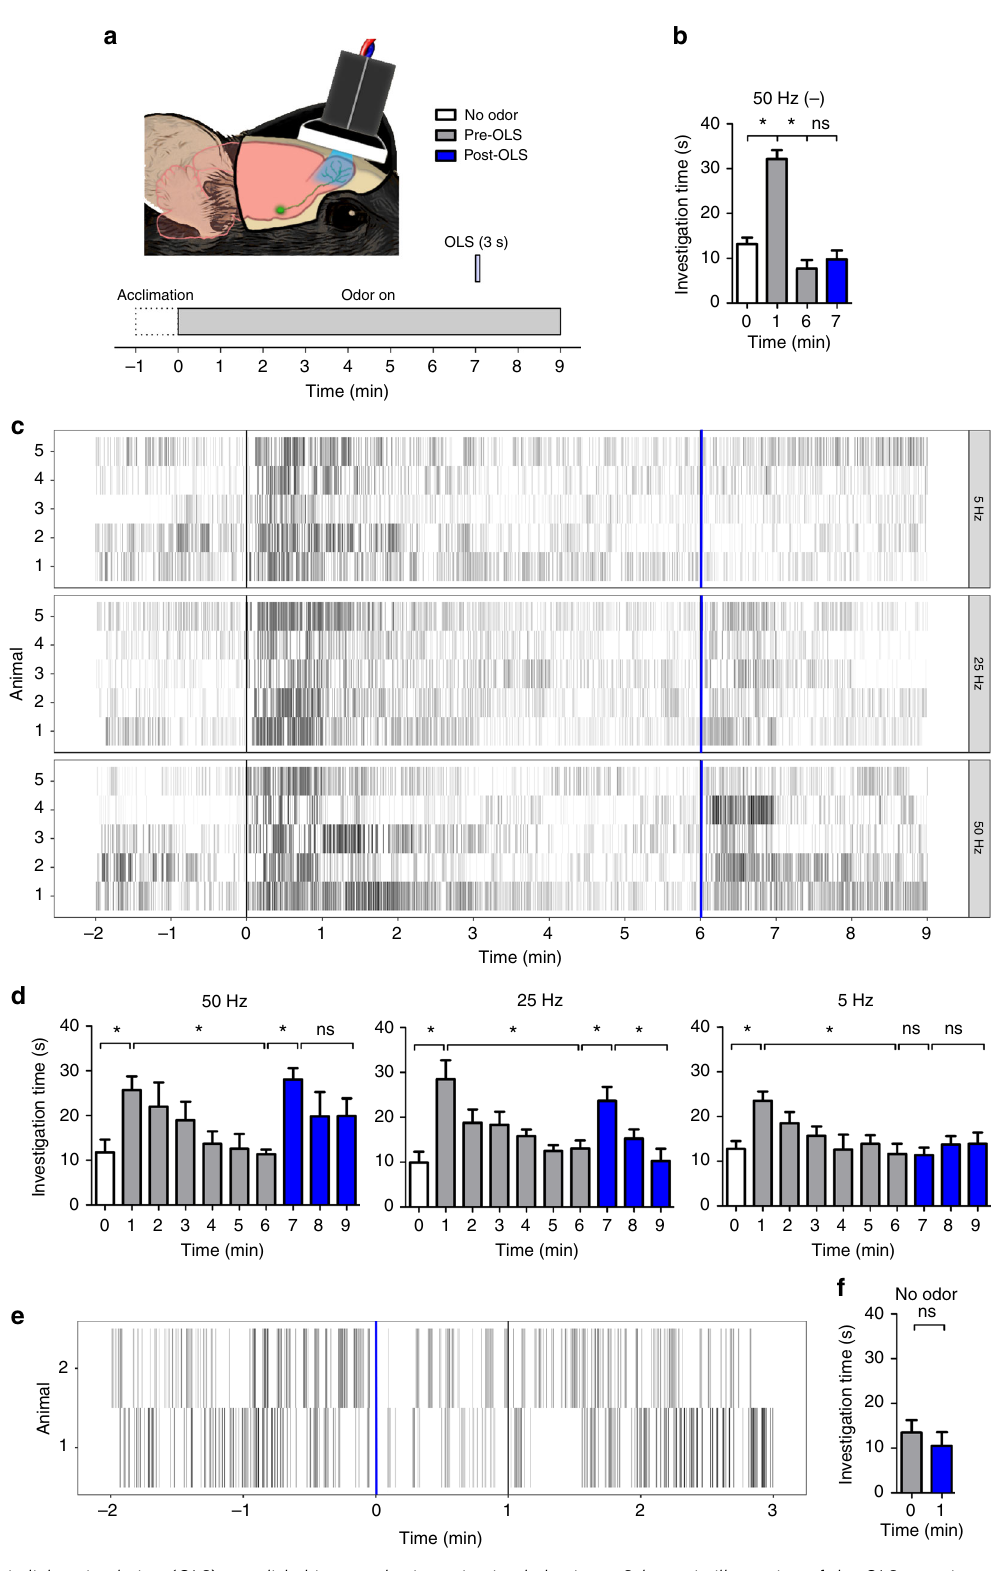
Fig. 4 Optogenetic light stimulation (OLS) can dishabituate odor investigation behavior. a Schematic illustration of the OLS experiment. b Investigation time (seconds ± s.e.m.) does not increase after 50 Hz OLS in WT (ChR2 − ) controls ( n = 5 mice). c Raster plots of the odor investigation behavior comparing OLS at 5, 25, and 50 Hz in the same mice ( n = 5 mice). d Investigation time in Ch2R + mice after the OLS is stimulation dependent: following 50 Hz OLS, investigation time increases and stays increased for at least 3 min. After 25 HZ OLS, investigation time also increases, but does not remain increased. 5 Hz OLS does not increase investigation time. e Raster plots of investigation behavior taken from two mice before and after OLS (blue line) in the absence of any odor stimuli demonstrating the OLS itself does not lead to increased snif fi ng. f Mean investigation times (seconds ± s.e.m.) taken from the minute before and after OLS in mice in the absence odor stimulation. * p < 0.05. Illustration by Ogg,